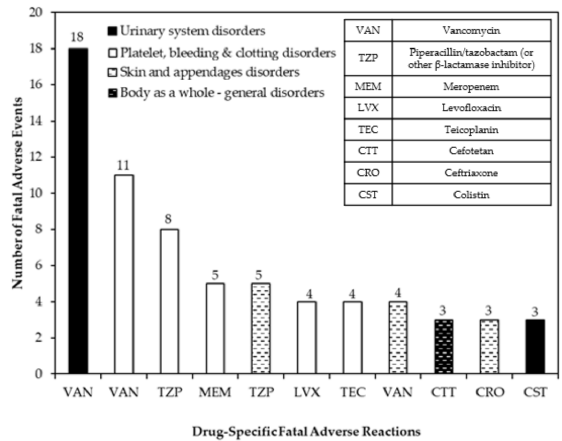
Figure 1. Specific antibiotic-induced adverse reactions resulting in at least three fatal cases over the study period.